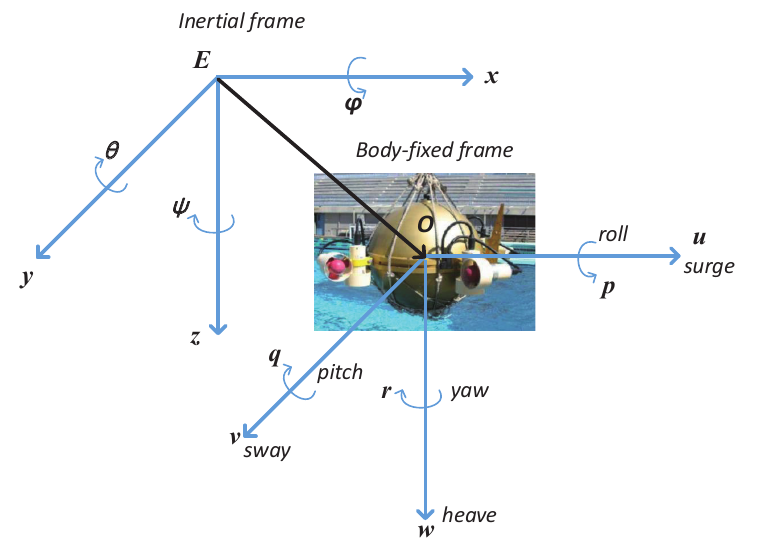
Figure 1. System coordinates of